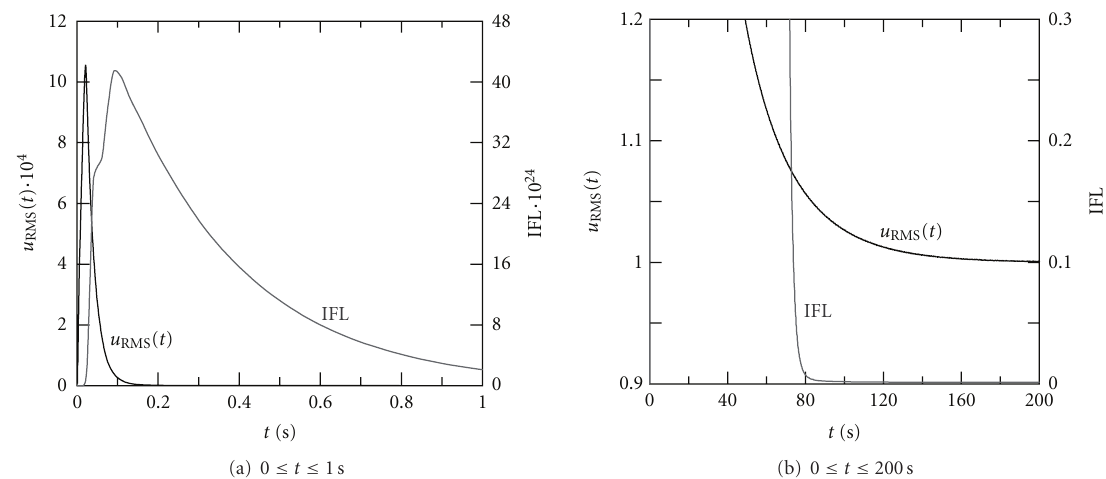
Figure 3: Time plots of u RMS ( t ) and IFL signals during the fading out of transient component (for zero initial conditions).